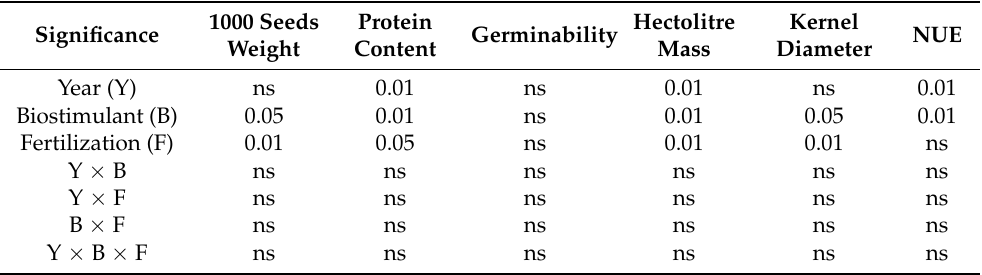
Table 4. Statistical analysis (significance ( p value) and interaction) of quality parameters.